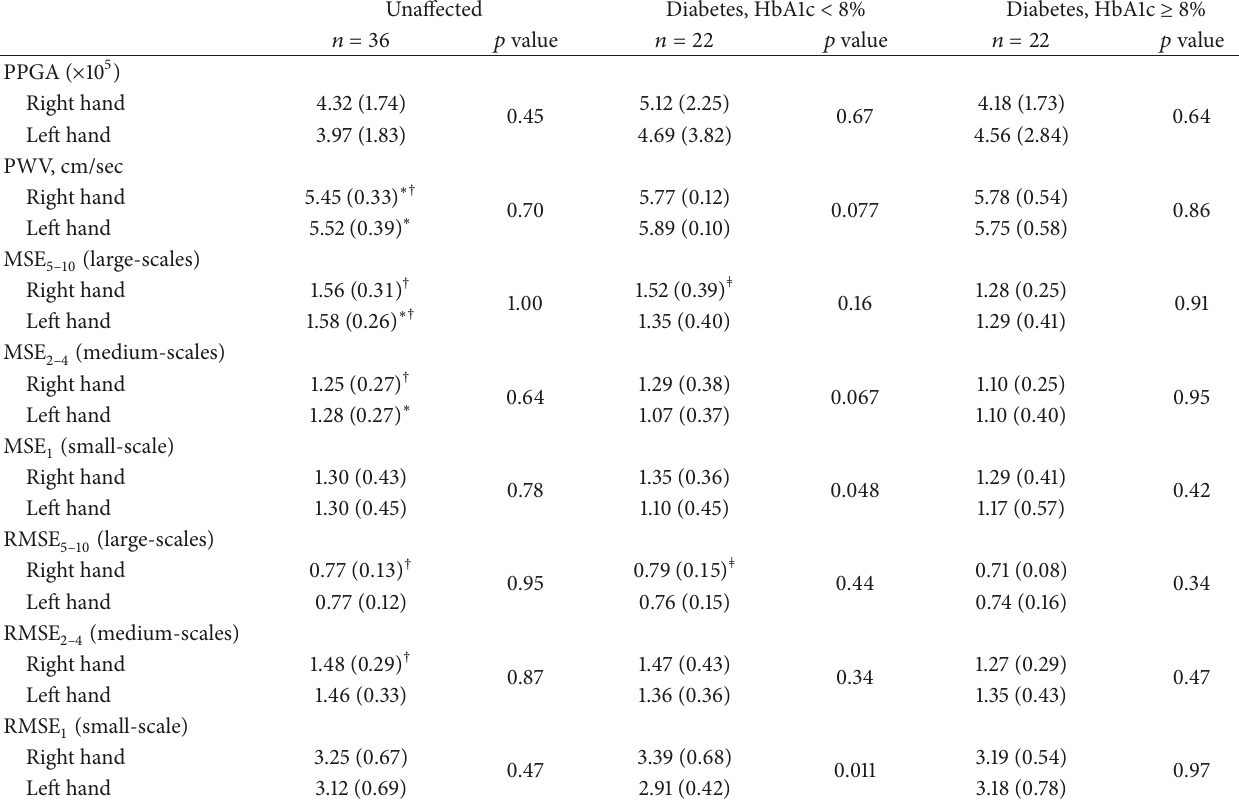
Table 2: Comparisons of photoplethysmographic pulse amplitudes, pulse wave velocity, multiscale entropy, and refined multiscale entropy between two hands and between